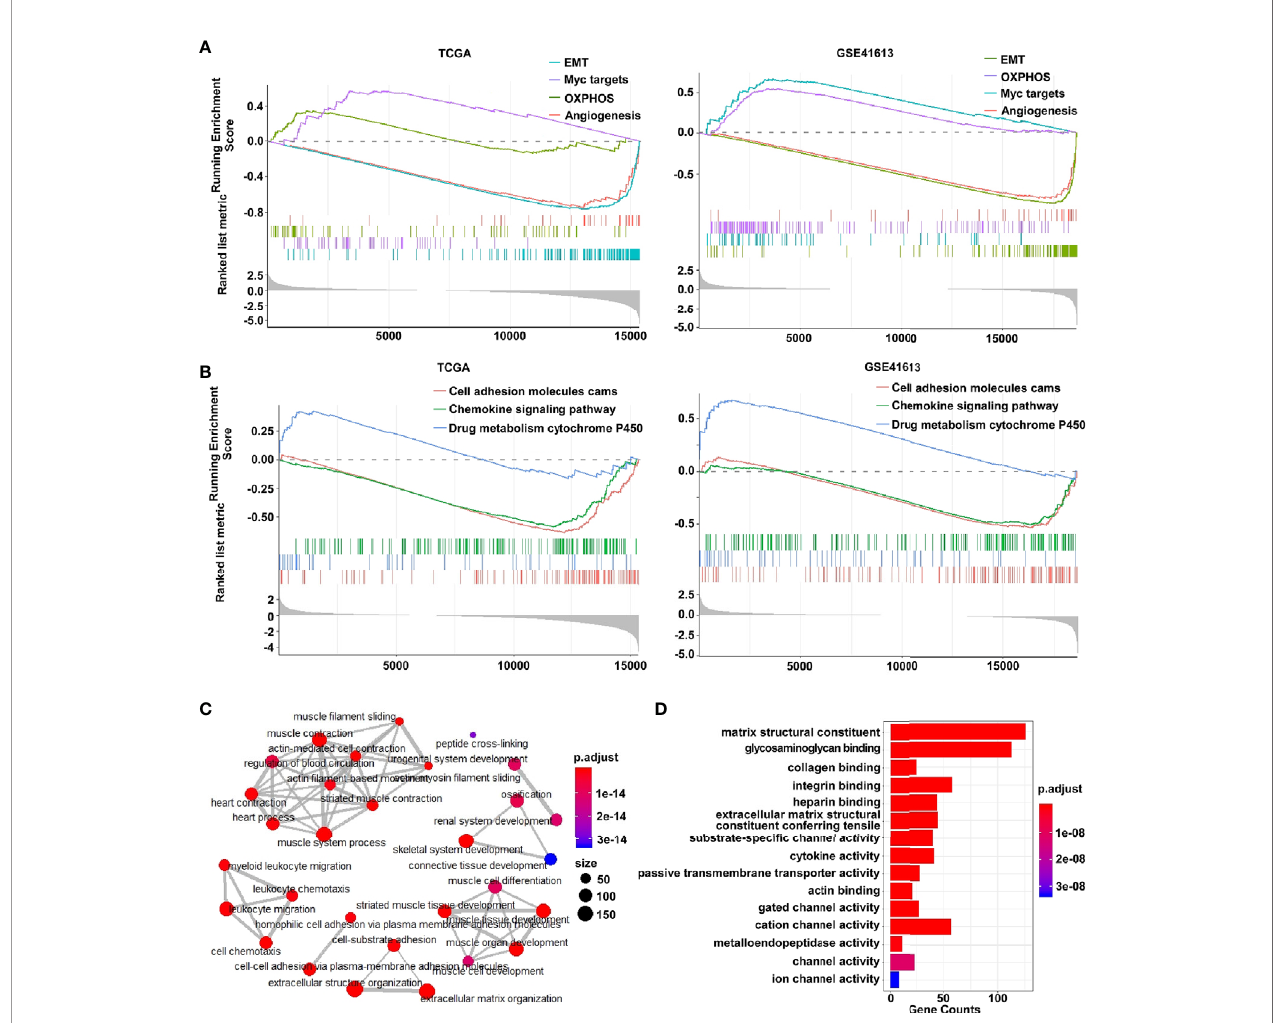
FIGURE 2 | The differentially expressed genes between E- and M-subtypes are enriched in EMT- and immune-associated signaling pathways in OSCC. (A) The hallmark modular and (B) the KEGG modular of GSEA analysis, and (C) the biological process modular and (D) the molecular function modular of Gene Ontology analysis show the DEGs are enriched in EMT-associated and immune-associated signaling